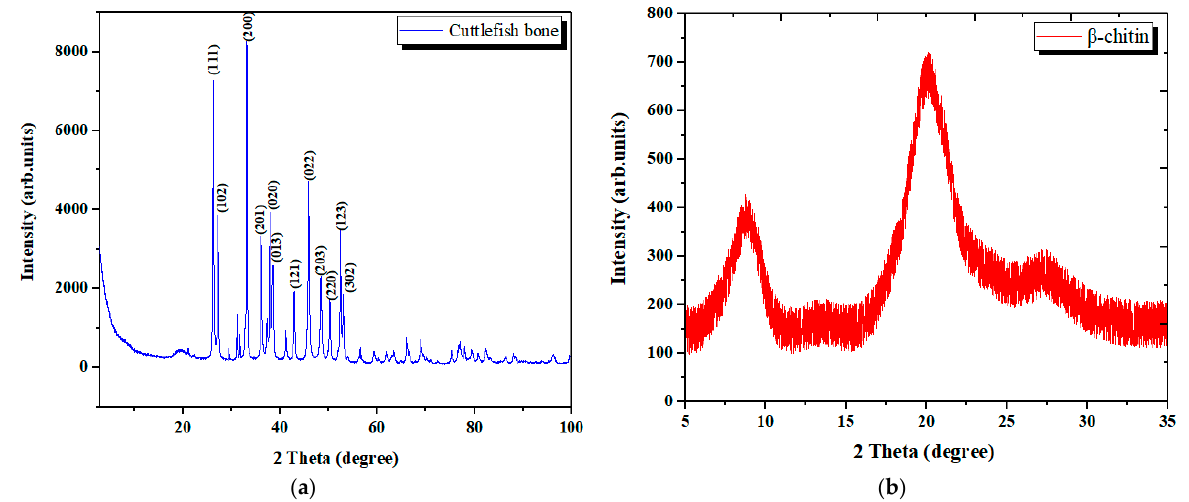
Figure 8. XRD spectra of cuttlefish bone materials: ( a ) XRD spectrum of raw cuttlefish bone powder; ( b ) XRD spectrum of chitin oligosaccharides isolated from the deproteinization liquid.